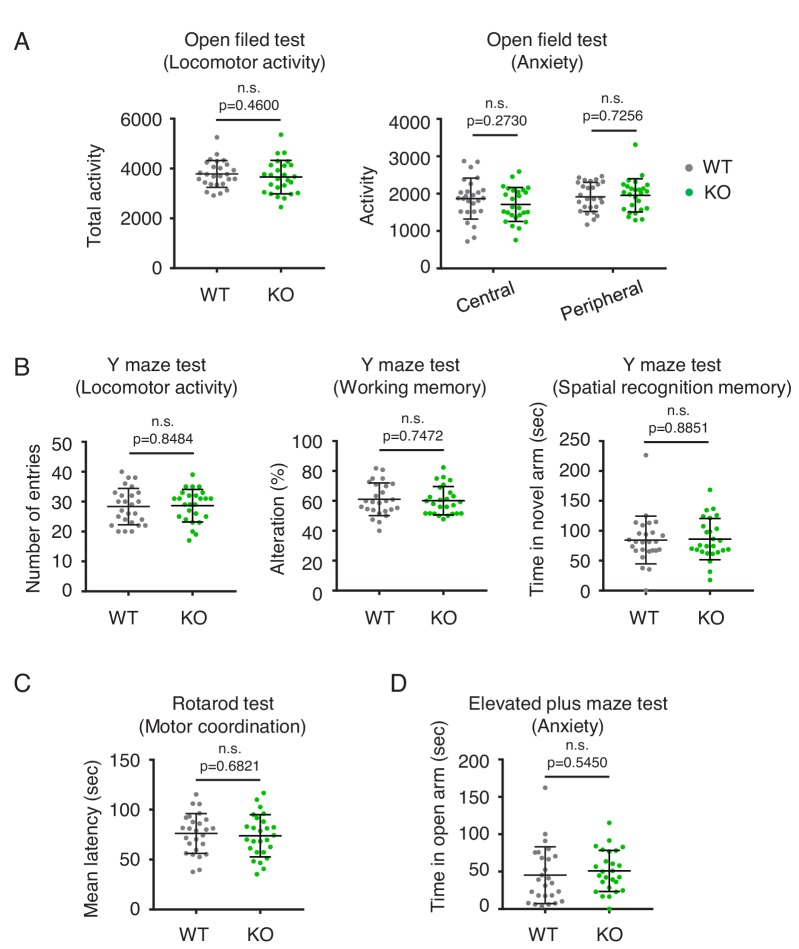
Behavior analysis of Drp1exonA-KO mice.(A) Open field test. Total activity (Locomotor activity) and percentage time spent in the central and peripheral regions (Anxiety). (B) Y-maze tests. Number of arm entries (Locomotor activity), spontaneous alternation (Working memory), and time in novel arm (Spatial recognition memory) were determined. (C) Rotarod test. (D) Elevated plus maze tests. Bars are mean ± SD (n = 26 control and 26 Drp1exonA-KO mice). Statistical analysis was performed using Student’s t-test. Source Data File List for Figures (file name).10.7554/eLife.44739.017Figure 4—figure supplement 3—source data 1.Data of behavior tests.